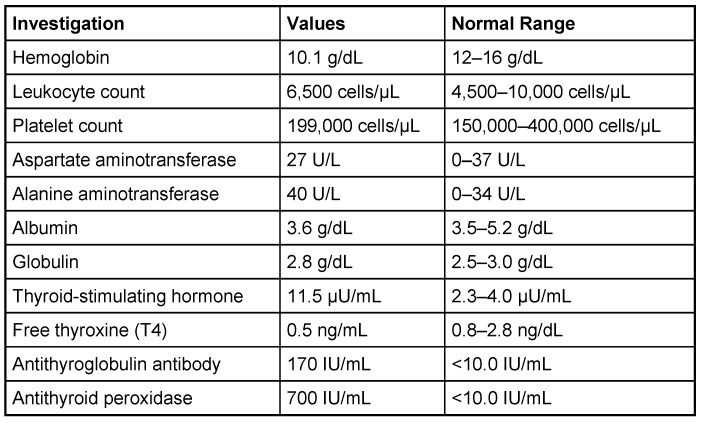
Laboratory studies